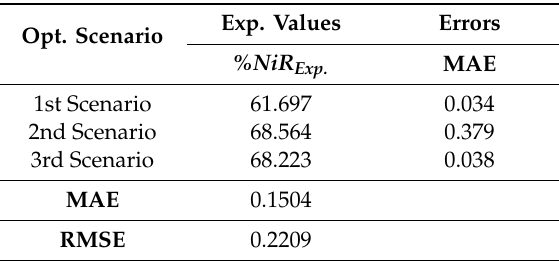
Table 12. Experimental output variable ( %NiR Exp. ) of the three biosorption optimization scenarios and errors